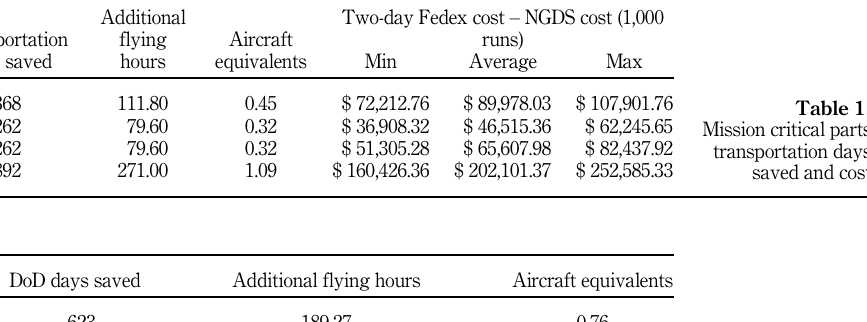
Table 2. DoD days